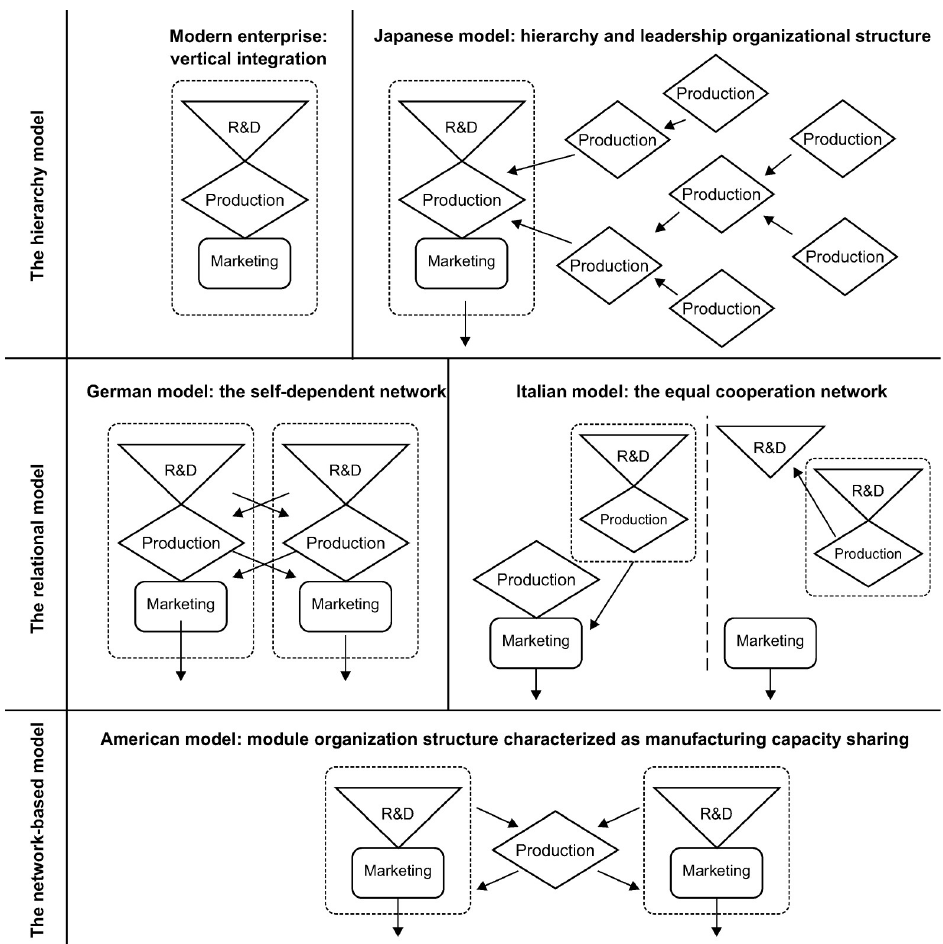
Fig 2. The organization mode of multinational company production networks. Spatiotemporal distribution of the value chain organization models of Hon Hai Precision Industry, Wistron Corporation, and AsusTeK.